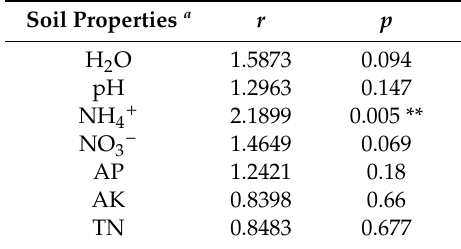
Table 2. The relationship between the soil parameters and the bacterial community structure in the rhizosphere. Soil Properties ª